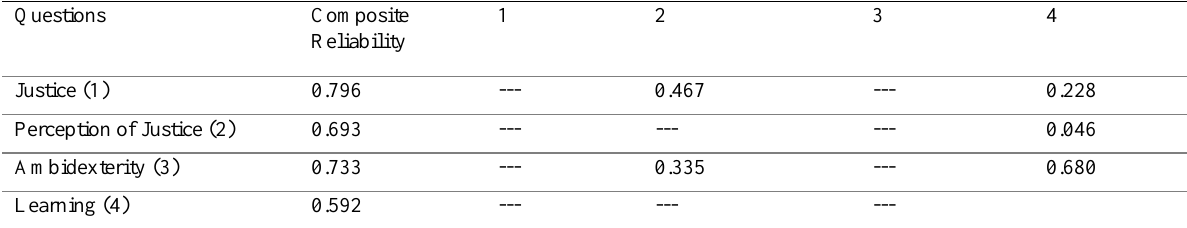
Table 6 : Table of Beta Values